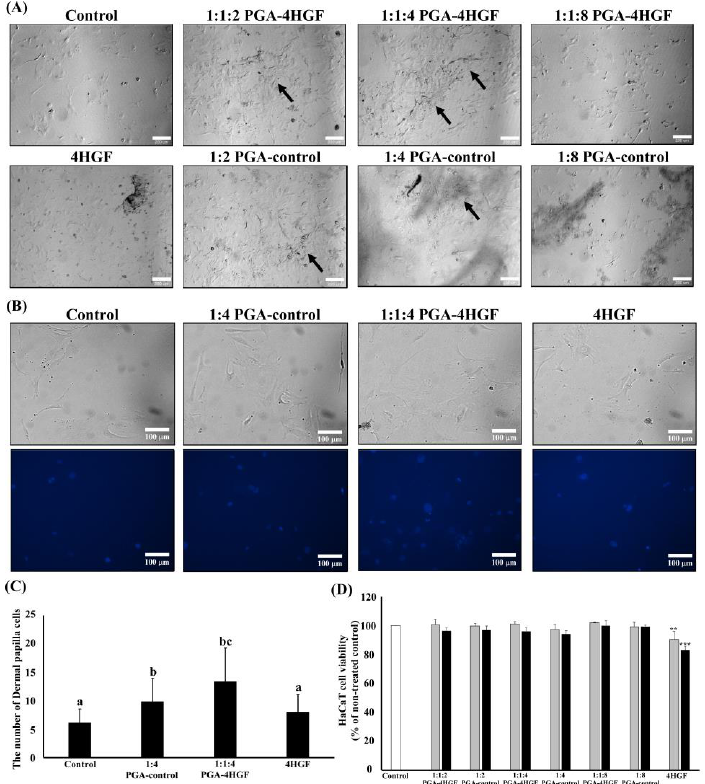
Figure 2. Effect of PGA-4HGF on primary dermal papilla cells and keratinocytes. ( A ) Primary dermal papilla cells (5 × 10 3 cells / well) were treated with PGA-HGF for 96 h at 37 ◦ C in Dulbecco’s modified Eagle’s medium (DMEM) media. The images of cell morphology and aggregation (black arrow) were taken after 96 h using a microscope (40 × magnification, scale bars: 200 µ m). ( B ) Primary dermal papilla cells (3 × 10 3 cells / well) were co-incubated with various samples and Hoechst solution for 24 h. The images were taken after 24 h using a microscope (100 × magnification, scar bars: 100 µ m). ( C ) The number of DPCs were counted using Image J program. Data represent means ± deviation (SD). Data were analyzed with one-way ANOVA / Duncan’s t -test. ( p < 0.05). Values with di ff erent alphabets in the same row are significantly di ff erent. ( D ) Cell proliferation e ff ects of PGA-4HGF on keratinocytes (HaCaT) cells (5 × 10 3 cells / well) in DMEM media for 24 h (grey bar: 1% of 4HGF, black bar: 2% of 4HGF). Each value represents the mean ± SD of three independent experiments. Data were analyzed with one-way ANOVA / Dunnett’s t -test (** p < 0.01, *** p < 0.001 vs. the non-treated